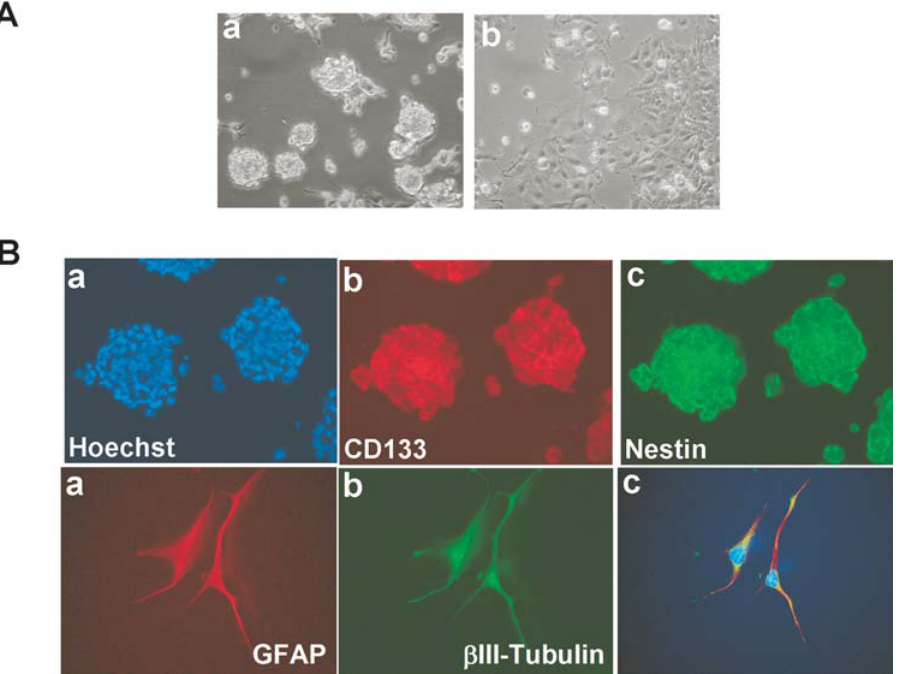
Figure 5. r 0 glioma cells form neurosphere-like tumor spheroids expressing neural stem cell markers, nestin and CD133. A ) Phase contrast microphotographs (magnification X20) of r 0 glioma forming (a) neurosphere-like structures in serumless Neurobasal medium supplement with EGF and FGF after 10 days in culture or (b) adherent culture in DMEM/F12 medium with 7% FBS. B ) Spheroids of r 0 cells were immunostained with (b) CD133 or (c) Nestin antibodies or nuclear counterstained with Hoechst 33258 (a). C) Differentiation potential of r 0 tumor spheroids. Multipotency was assayed by immunofluorescence for neuronal ( b III-tubulin) (a, c) and glial (GFAP) (b a, c) markers.